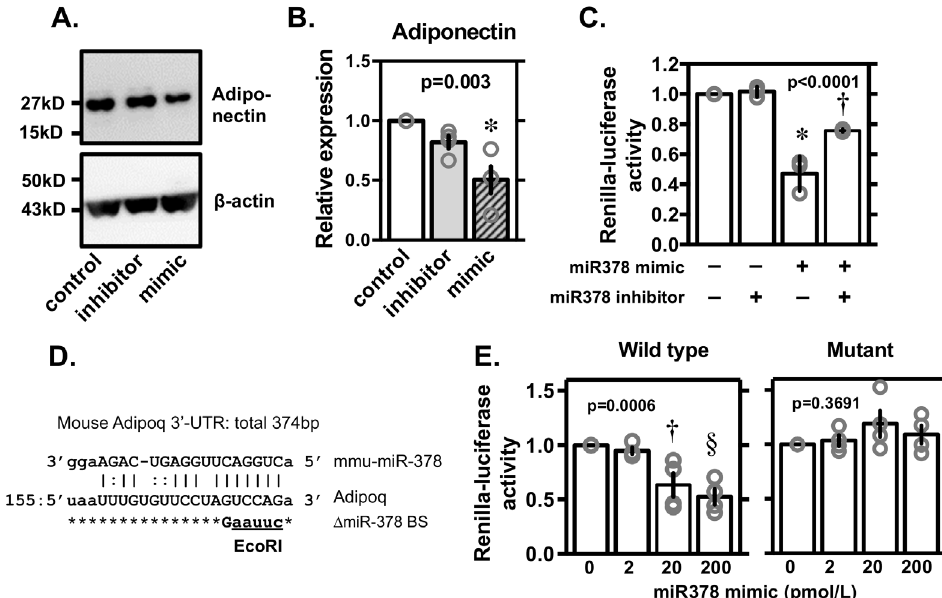
Figure 4. Representative blot (A), average expression levels of adiponectin protein (B) and Renilla-luciferase activity in HEK293T cells overexpressing the inhibitor or the mimic of miRNA-378 (C); Design of D miR-378 binding site (BS) (D); Effects of overexpressing the mimic of miRNA-378R on the Renilla-luciferase activity in HEK293T cells with wild type or a deleted mutant of the miR-378 binding on 3 9 -UTR (E). Expression levels normalized to those of b -actin. Individual values are shown with mean 6 SE (n=4). p values are shown for multigroup comparison by non-parametric Kruskal-Wallis test. *p , 0.05, { p , 0.01 and 1 p , 0.001 vs . controls or 0 for unpaired two group comparison by Wilcoxon-Mann-Whitney test.